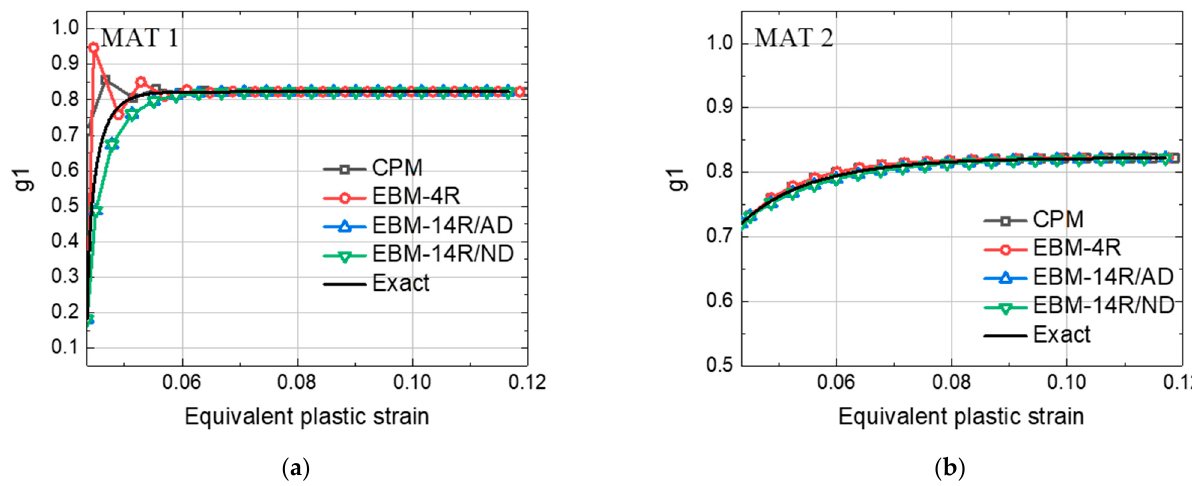
Figure 8. Evolutions of the state variables g for different stress integration algorithms with strain increment ∆ ε xx = 5 × 10 − 3 : ( a ) MAT 1 and ( b ) MAT 2.